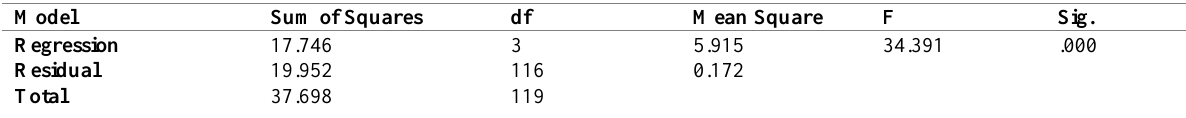
Table 8: Regression analysis of ANOVA Test